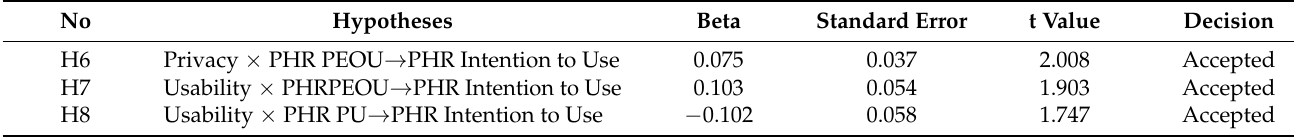
Table 5. Moderating